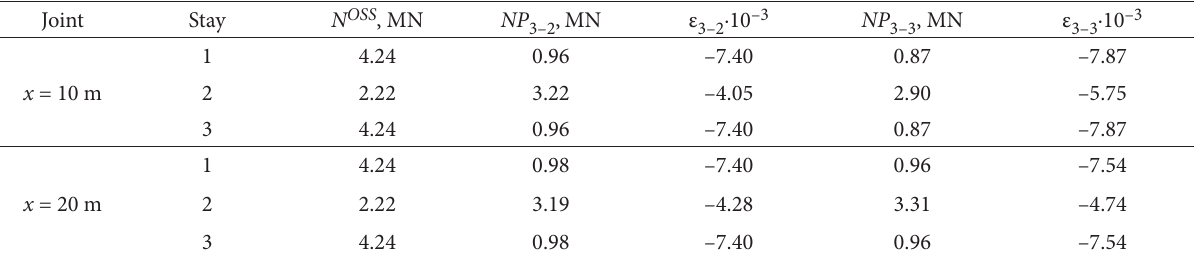
Table 2. Obtained values for bridge B 3